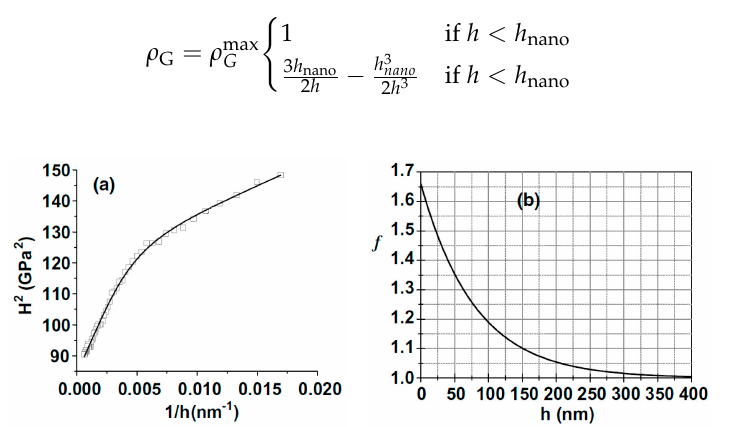
Figure 6. Indentation size effect in polished MgO: ( a ) experimental results versus the modified Nix and Gao model presented by Feng and Nix [98] ( H 0 = 9.19 GPa; h ∗ = 102 nm ) ; ( b ) variation of f versus h (after Feng and Nix [98]).